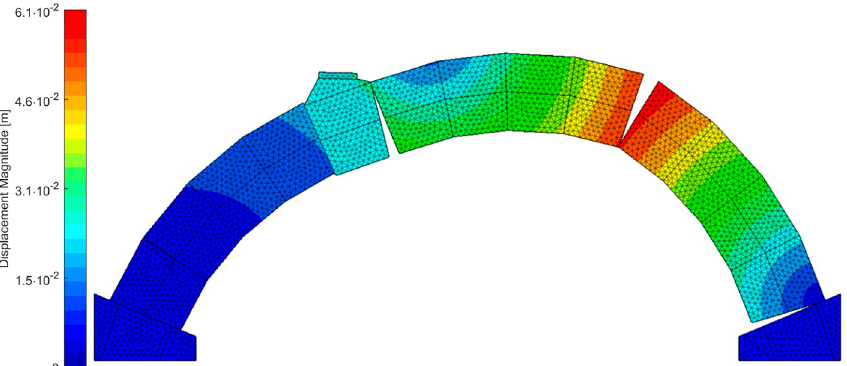
Figure 25. Failure mode of densely meshed geometry for best set of material parameters using ob- jective function 2; the colour legend represents the displacements in metres.